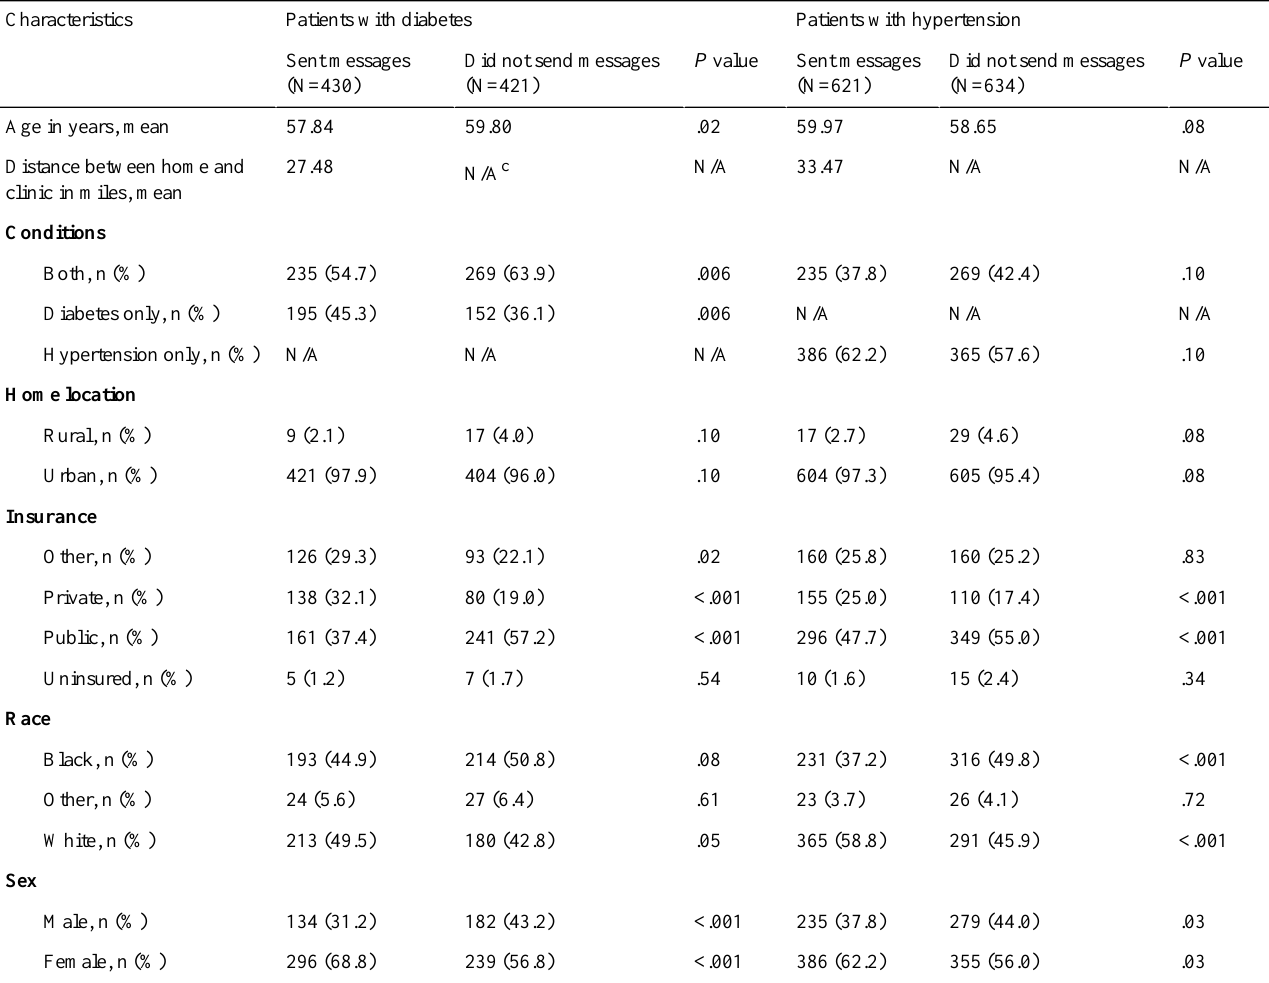
Table 2. Comparison of study population’s characteristics by use of secure messaging in 2017. a,b